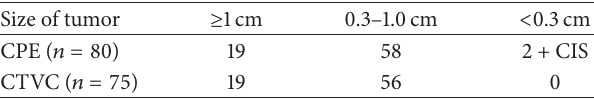
Table 3: Number of bladder growths detected by virtual and conventional cystoscopies according to